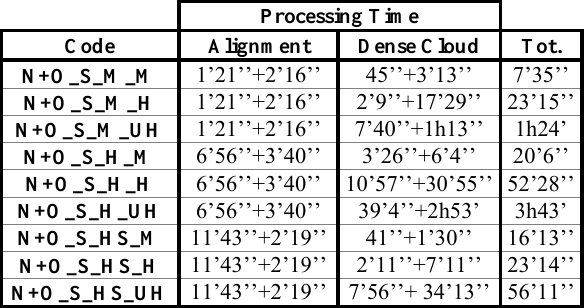
Table 4. Processing Time in case of sparse and dense point cloud for nadiral+oblique configurations